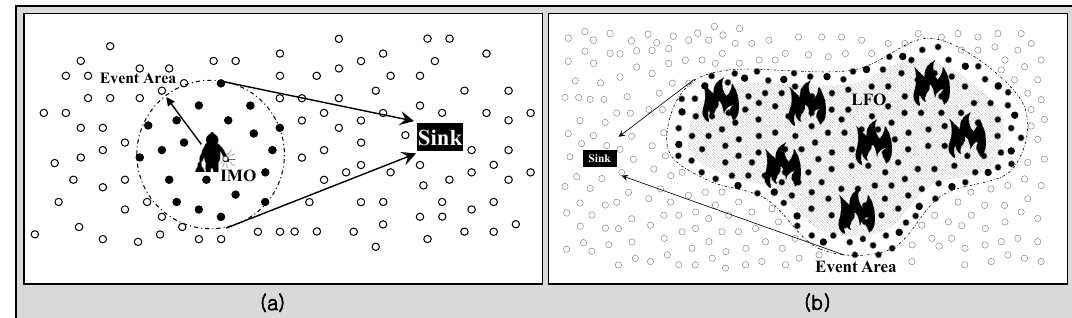
Figure 1. Data dissemination from an event area to a sink: ( a ) individual mobile objects (IMOs) vs. ( b ) large-scale fluid objects (LFOs).